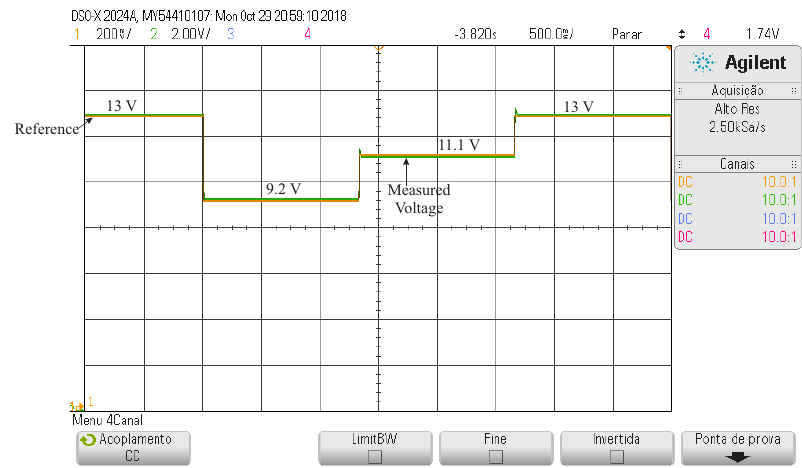
Figure 9. Response of the SMPI for several references values of voltages.